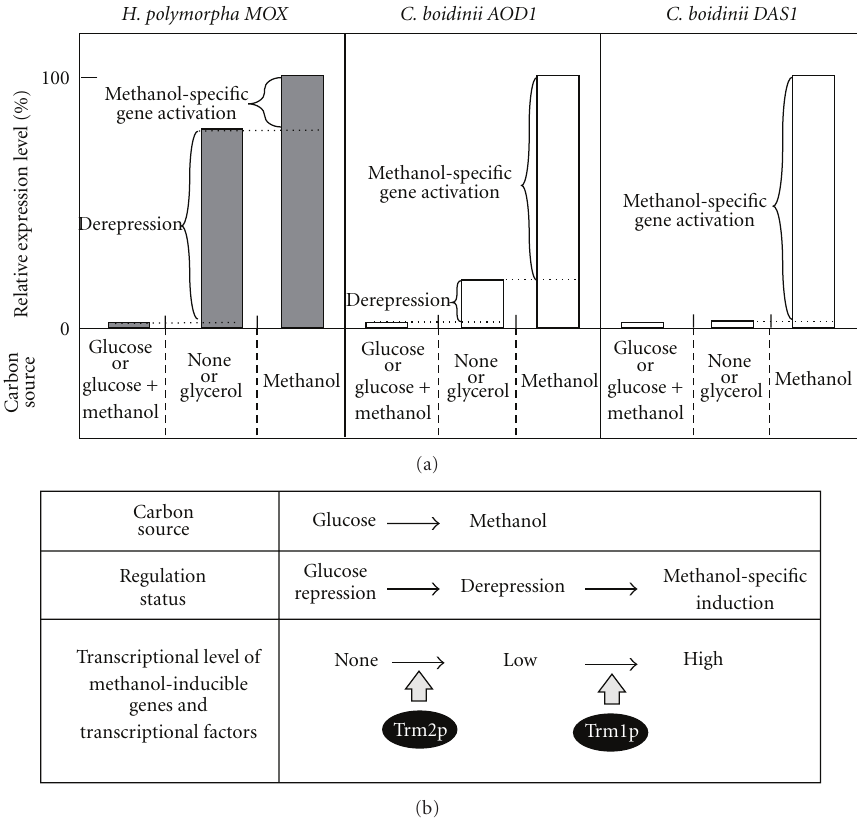
Figure 2: Molecular mechanism of methanol-inducible gene expression. (a) Relative expression levels of H. polymorpha MOX (encoding AOD), C. boidinii AOD1 , and C. boidinii DAS1 during growth on various carbon sources. On glucose-containing media, expression is completely repressed. When glucose is completely consumed or cells are shifted to glycerol medium, a derepressed level of expression of the AOD genes is induced (derepression) and the extent of derepression of the AOD genes di ff ers between H. polymorpha and C. boidinii . When cells are grown on methanol, the maximum level of expression of AOD genes is achieved not only by derepression but also by methanol-specific gene activation. The induction of DAS1 on methanol medium is achieved only by methanol-specific gene activation. (b) During growth on glucose, expression of methanol-inducible genes is repressed. When cells are shifted to methanol, initially, a Trm2p- related derepression event occurs followed by a Trm1p-related methanol-specific gene